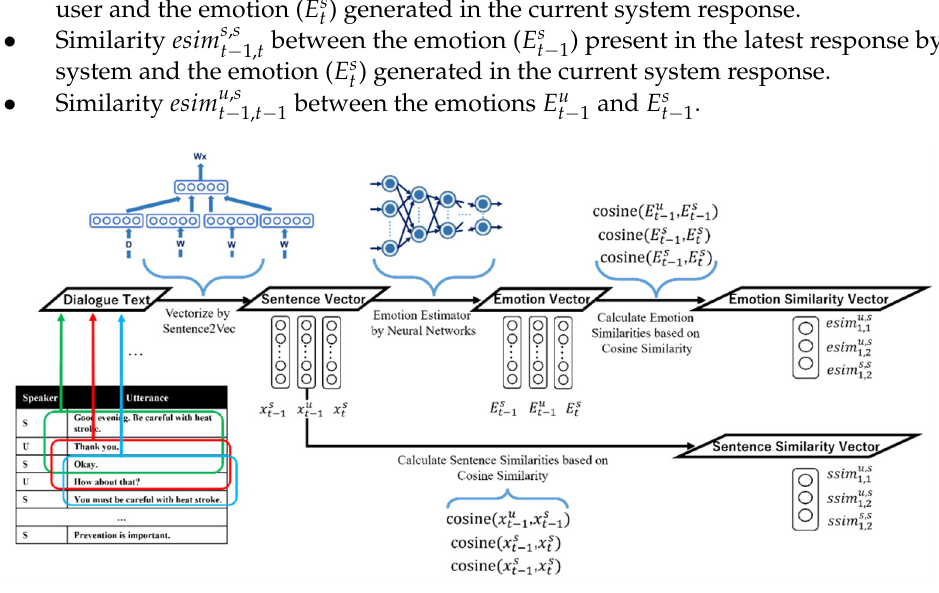
Figure 3. Extraction flow of emotion/sentence similarity vector.